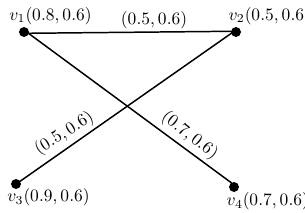
Figure 1. A five-rung orthopair fuzzy